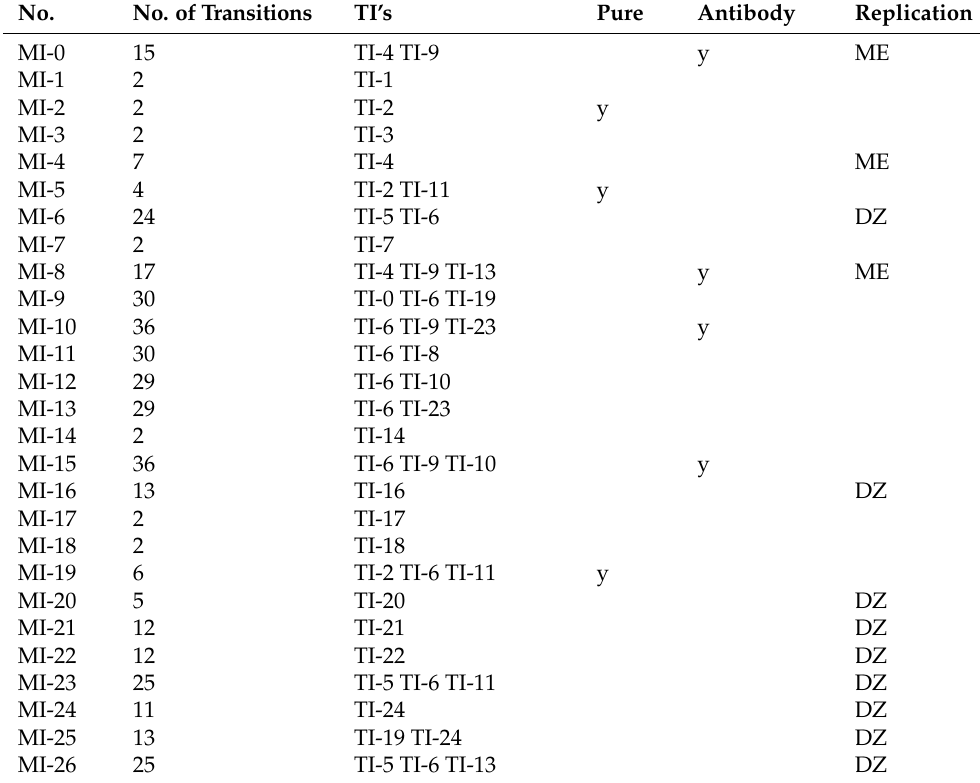
Table A6. List of the 66 Manatee invariants (MIs). The columns “pure” and “antibody” indicate whether the MI is pure and whether the production of antibodies is part of the MI, respectively. The column “replication” indicates in which compartment(s) replication of activated B cells or memory B cells can occur; ME means the medulla and DZ means the dark zone. MIs that describe no replication of cells have an empty entry in the “replication”